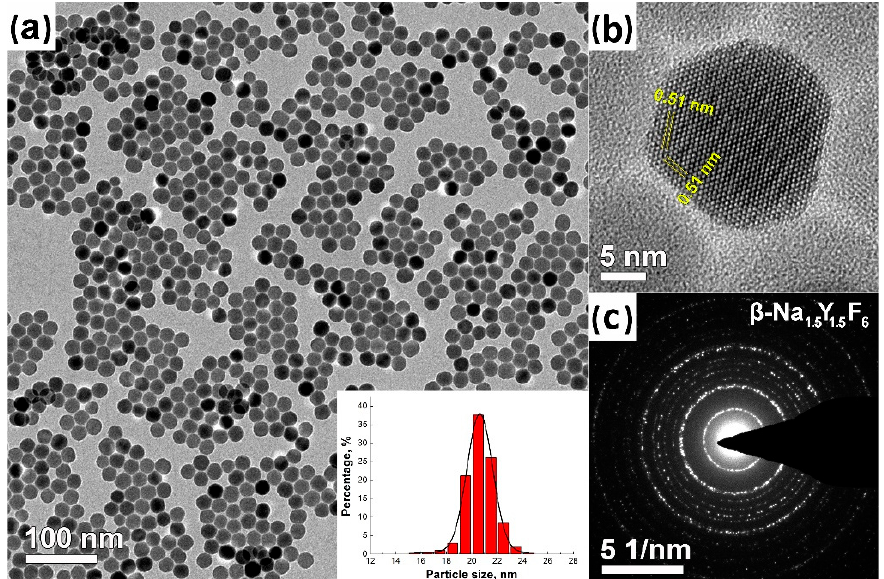
Figure 5. ( a ) Bright field TEM image with the particle size distribution histogram (insert); ( b ) HRTEM image of an individual particle close to the [0001] direction; ( c ) SAED pattern of β - Na 1.5 (Y 1.17 Yb 0.3 Er 0.03 )F 6 NPs, synthesized by thermolysis method.